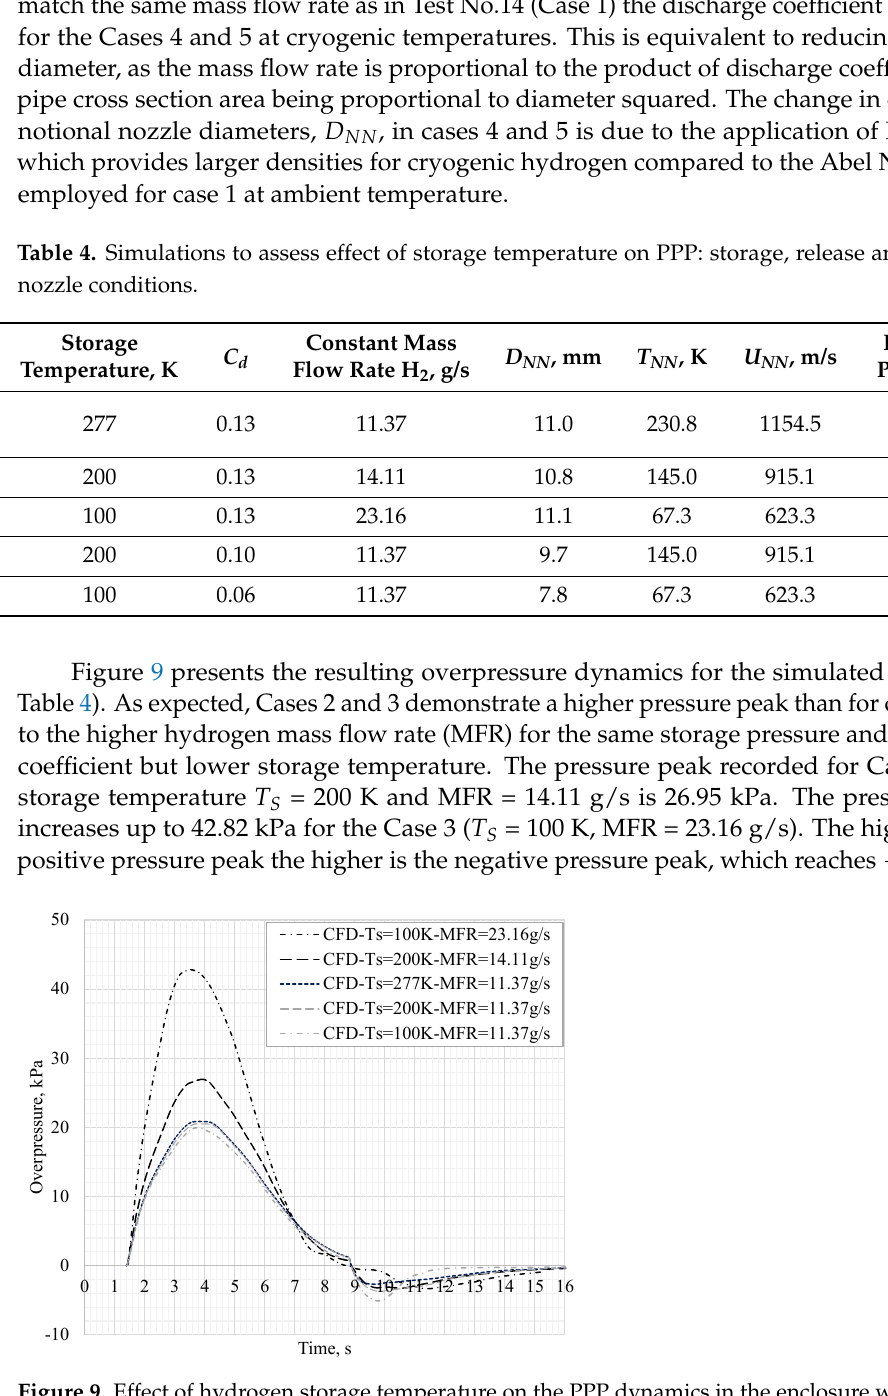
Figure 10. Effect of hydrogen storage temperature on volumetric flow rates entering and exiting the enclosure for the two limiting cases 1 (T S = 277 K) and 3 (T S = 100 K). 5. Conclusions